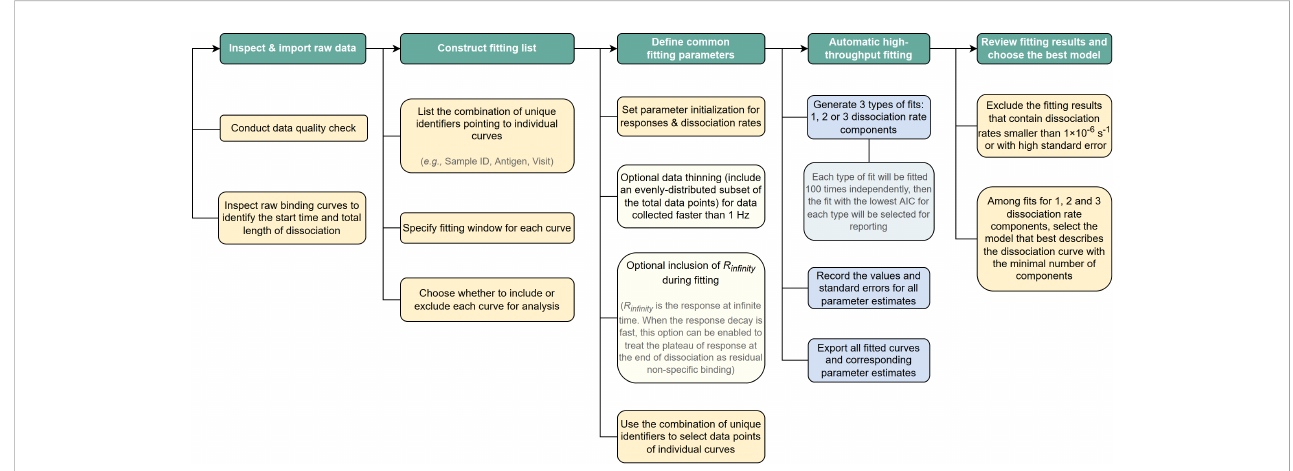
FIGURE 2 Schematic of the steps used to perform PAART analysis. A fl ow chart showing step-wise procedure for performing PAART analysis.